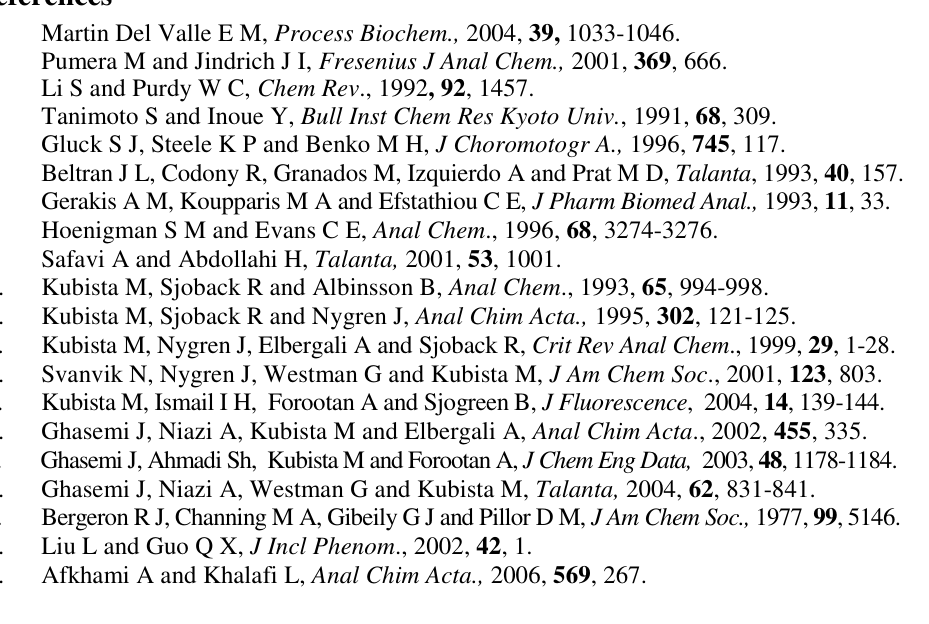
Figure 6. Distribution of major species of C Figures 1-2, in (I) pure water and (II) water- β -CD (6×10 -3 mol L -1 )